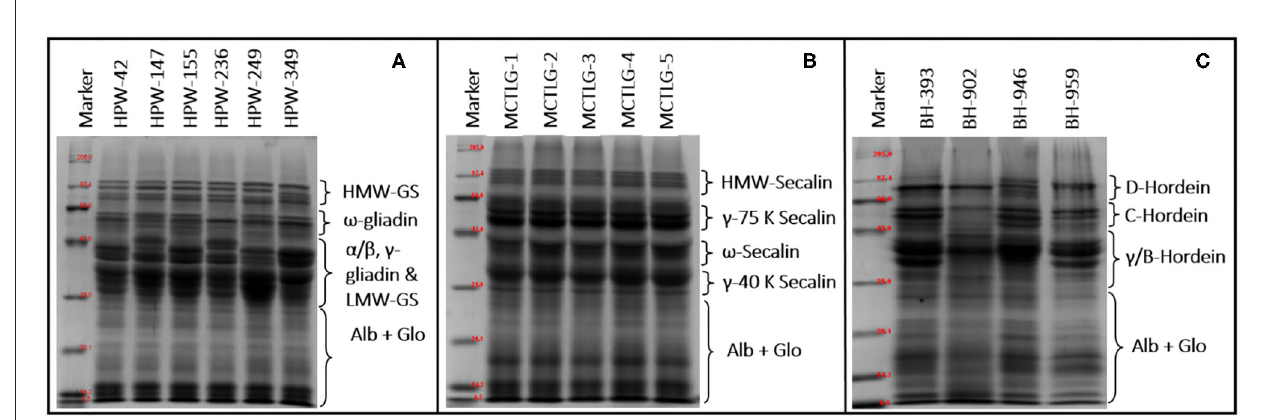
FIGURE 3 | SDS-PAGE of flour proteins from (A) wheat, (B) rye, and (C) barley cultivars under reducing conditions.